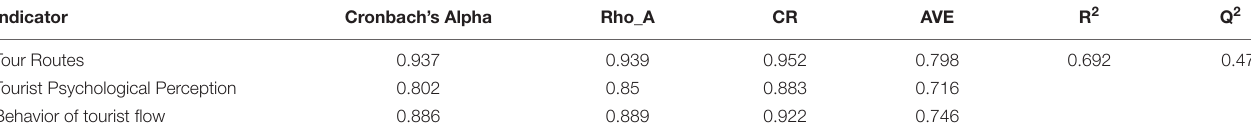
TABLE 4 | Results of model reliability validity test and fitting index.